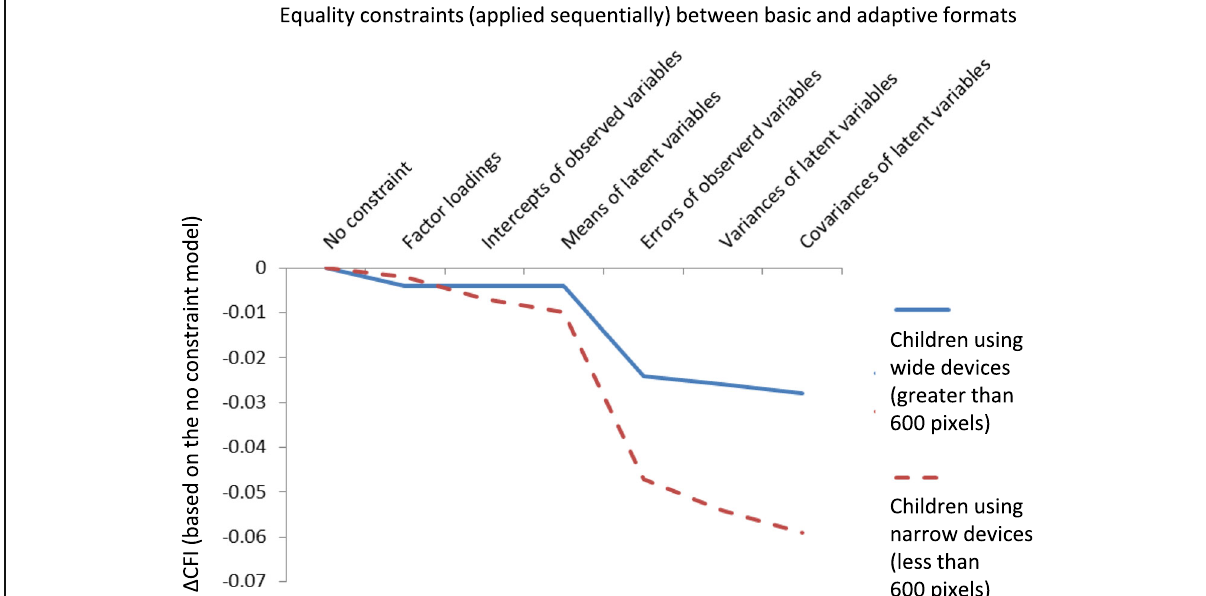
Fig. 6 Effect of equality constraints on Δ CFI for small and large-screen devices. CFI: comparative fit index. Based on the first model (no constraints), each sequential constrained model showed that the goodness of model fit (CFI) decreased ( Δ CFI). Δ CFI > 0.02 was used to indicate that the equality constraint is not applicable. Factor loading (path coefficient from latent variables to observed variables), intercepts of observed variables (estimated average for each item), and mean of latent variables (estimated average of measured concept (QOL subscales)) were judged to be comparable between basic and dynamic formats. Errors of observed variables (variance of each item) among children using narrow-screen devices (less than 600 pixels) were judged to be different to those among children using wide-screen devices (greater than 600